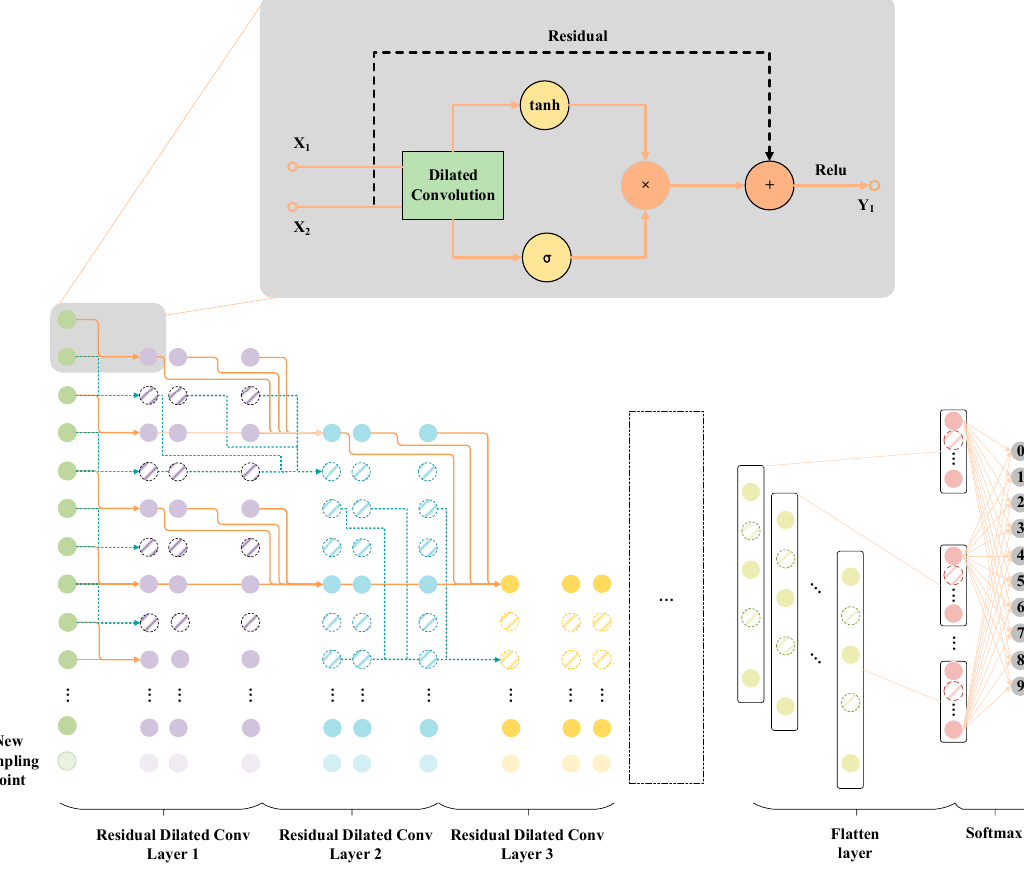
Figure 1. The overall framework of proposed SRDCNN model.